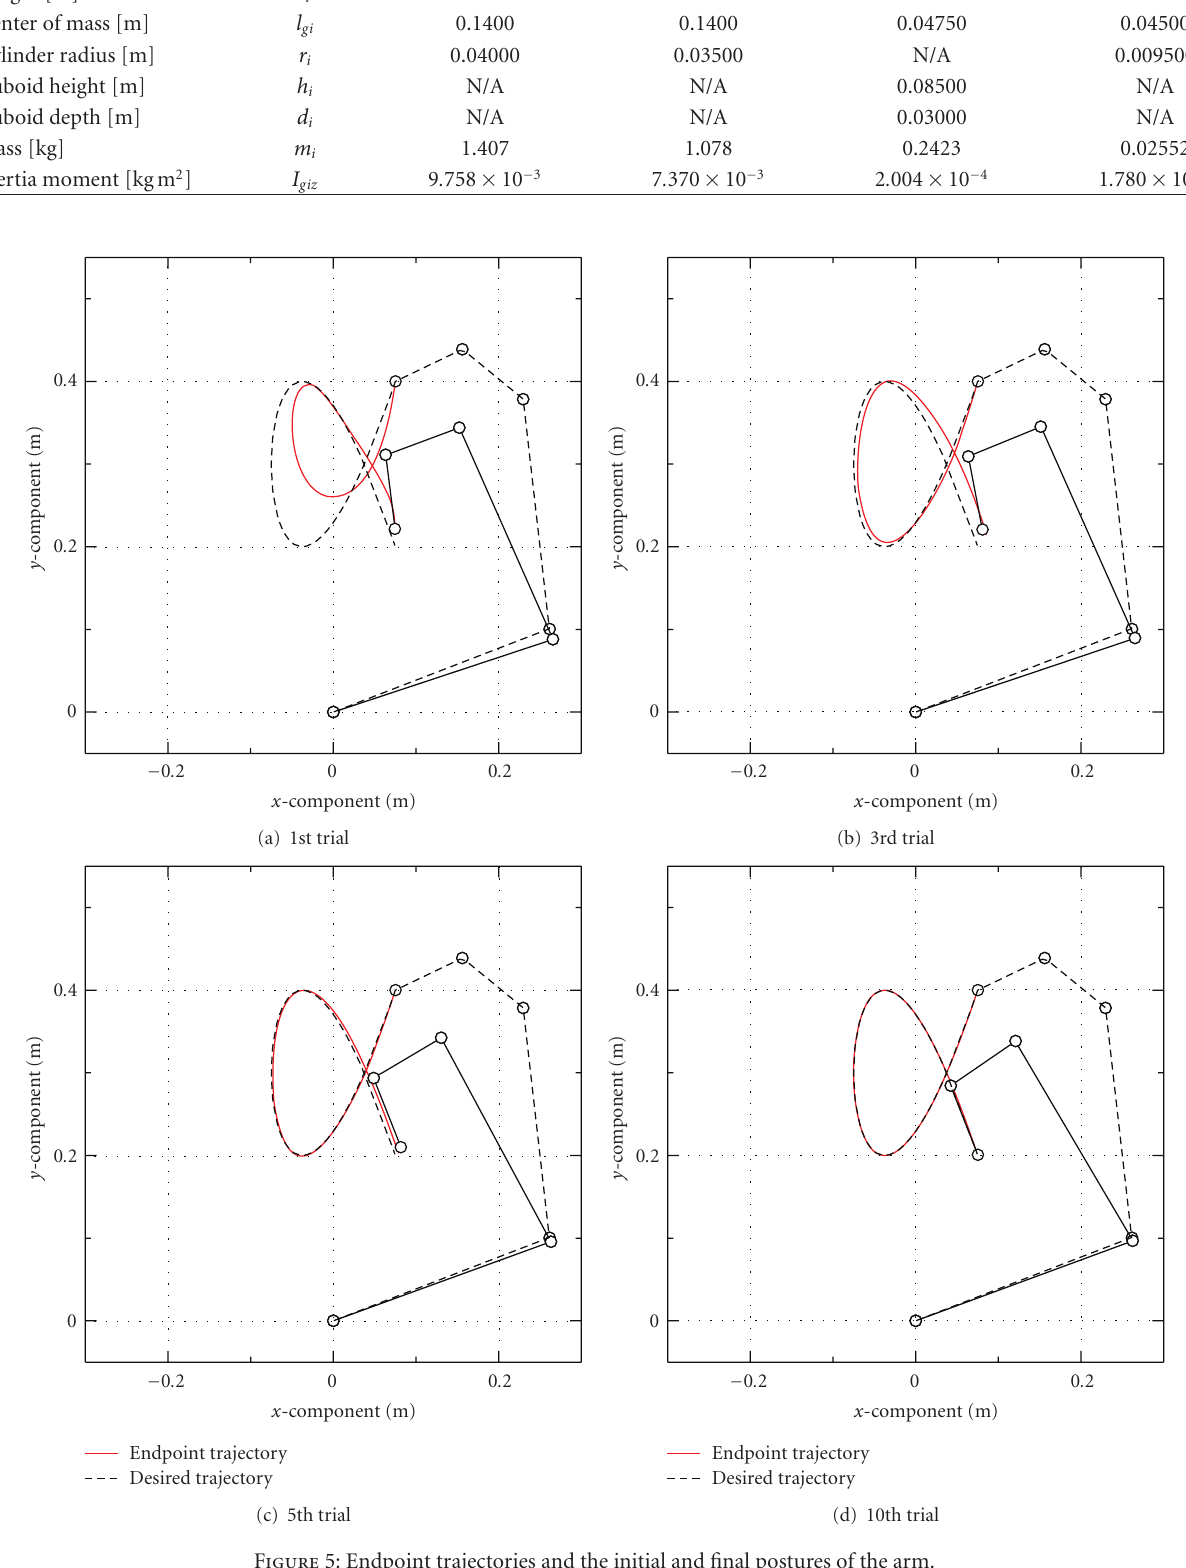
Figure 5: Endpoint trajectories and the initial and final postures of the